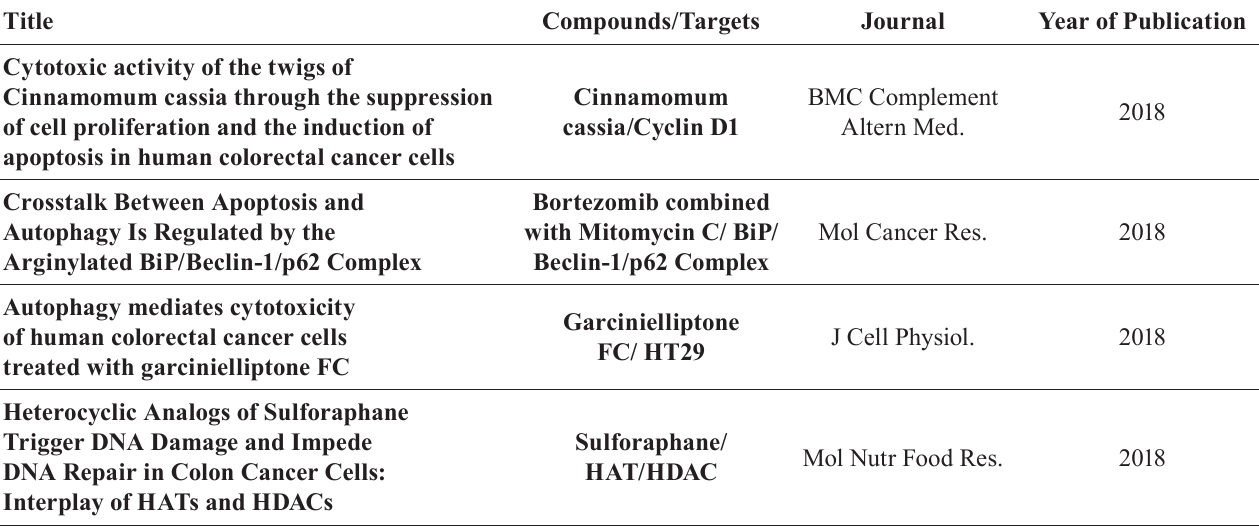
TABLE II – Potential CRC-related drugs identified in PubMed articles, followed by related tumor targets and their